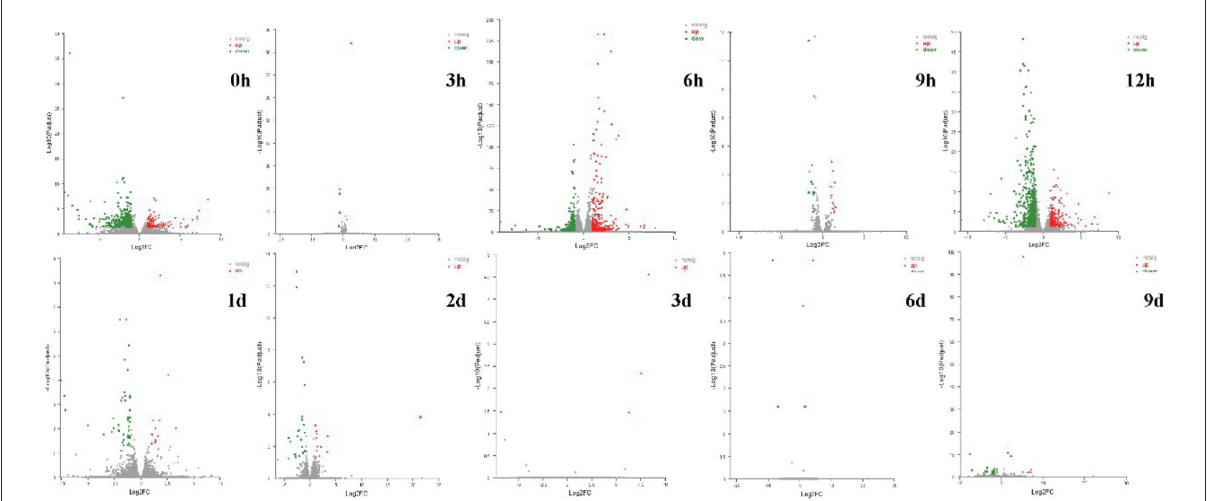
FIGURE5 Volcano plot of DEGs (|log2FC| > 1, p -adjust < 0.05) of strawberry at different time points after treatments. Red and green dots represent the upregulated and downregulated gene transcripts, respectively, and gray dots represent the gene transcripts that expressed differentially but have no significant difference.